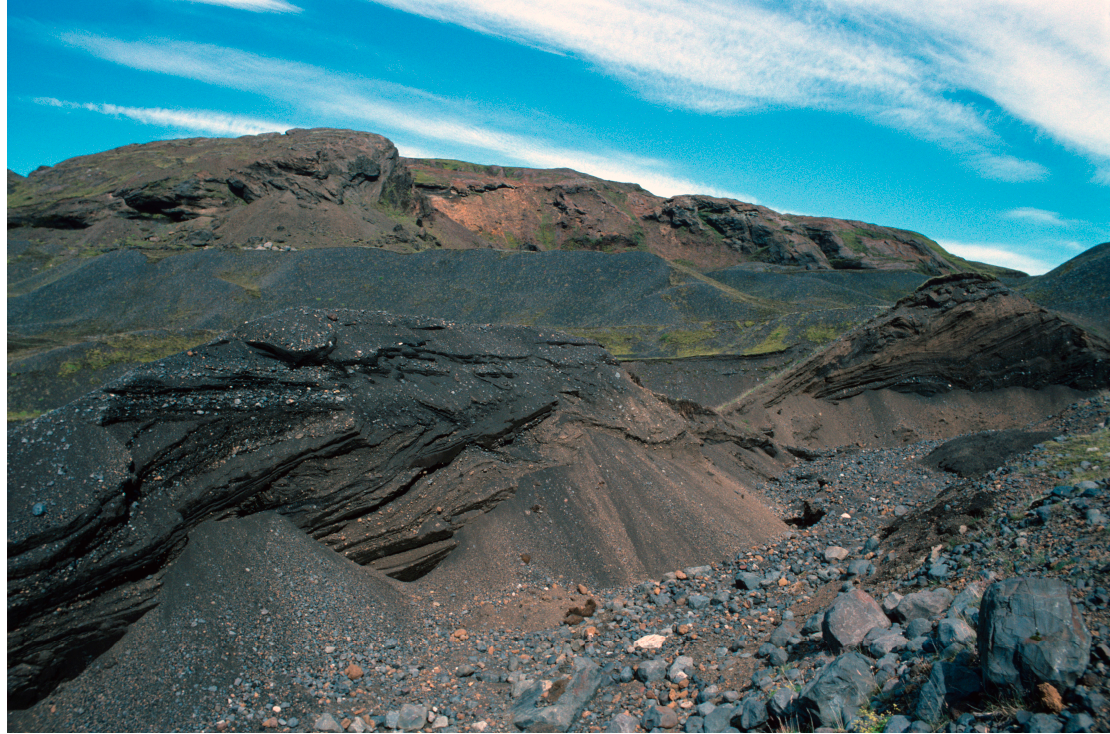
Figure 17. Exposure through deposits classified as glacilacustrine deposits modified by glacifluvial processes on the inner northern Sandfellsjökull foreland. Delta foreset bedded gravels and sands are truncated and overlain by glacifluvial outwash.